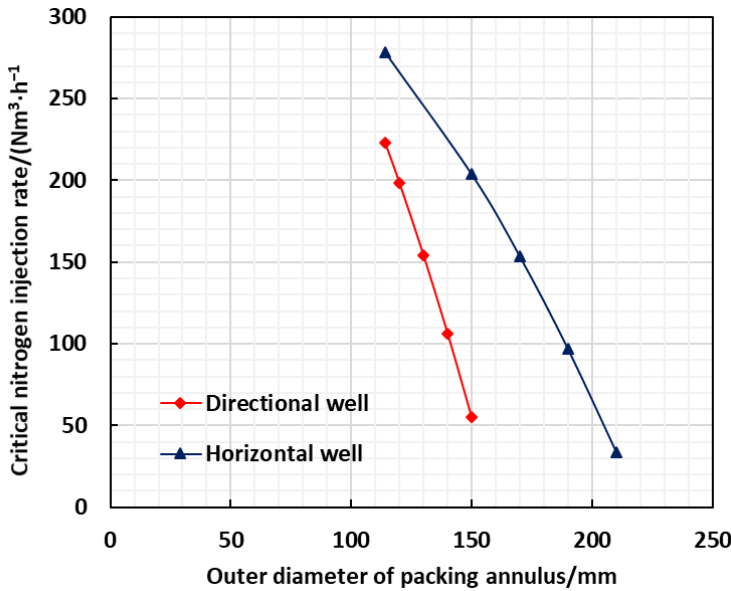
Figure 7. Relationship between annular packing outer diameter and critical nitrogen injection displacement.